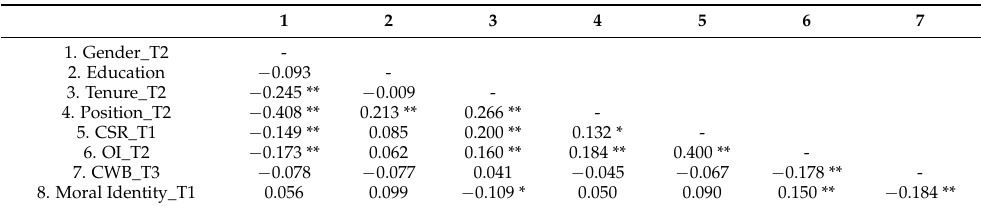
Table 2. Descriptive